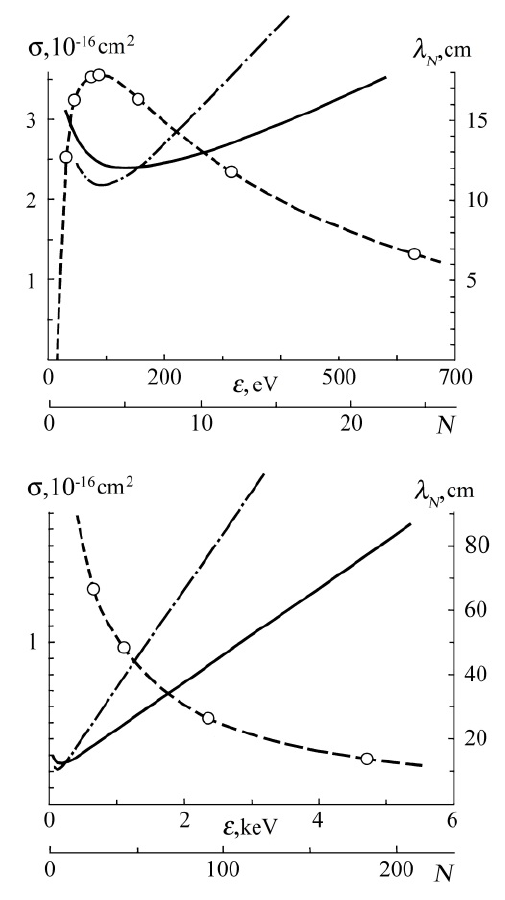
Fig. 4. Dependence on the electron energy ε of the argon ionization cross-section (dashed lines), the mean free path λ 0 of an electron with energy ε between ionizing collisions (dashed- dotted lines) and the average electron path between ionizing collisions λ N at room temperature 293 K and argon pressure 1.0 Pa (solid